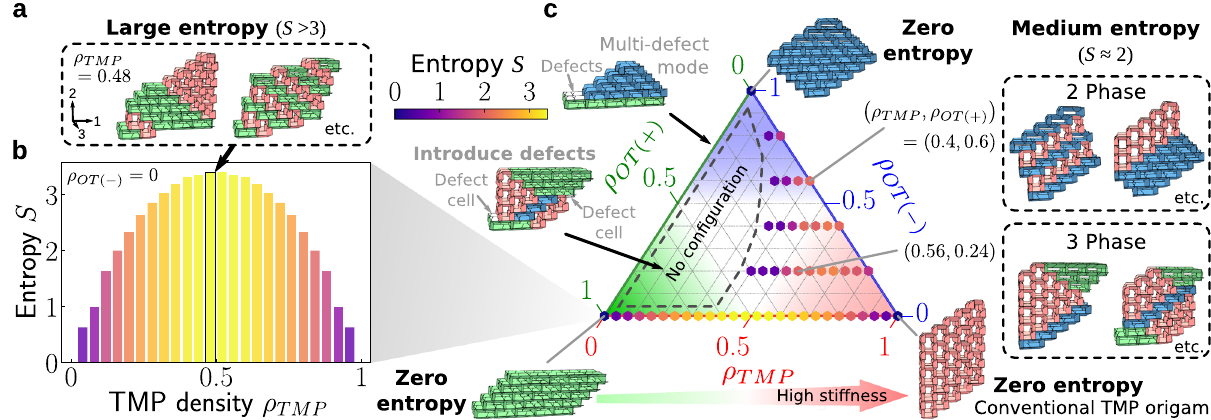
Fig. 4 Reprogrammable geometric information capacity of a 5 × 5 origami tessellation. a The tessellation composed of TMP and OT( + ) cells (i.e., no OT( − ) cell) shows b the drastic change of the Shannon entropy S as a function of ρ TMP = n TMP /25. The maximum entropy is achieved at ρ TMP = 0.48 (see the example con fi gurations in the dashed box). c All possible con fi gurations for the 5 × 5 origami tessellation are characterized by the entropy S and the results are plotted in the ternary diagram, which represents a three-component origami system. The color intensity of each hexagonal marker indicates the value of the Shannon entropy S . Note that the empty region bounded by the dashed line in the ternary diagram indicates no con fi guration. The plot shown in b , represents the change of S along the bottom axis in this plot, i.e., ρ OT ( − ) = 0. By embedding different phases in the tessellation, the origami system can transit to the medium entropy combinations ( S ≈ 2). See the example con fi gurations in the dashed boxes. In addition to the three-component system, defect unit cells can be embedded in the tessellation (see the left two inset illustrations for the defect